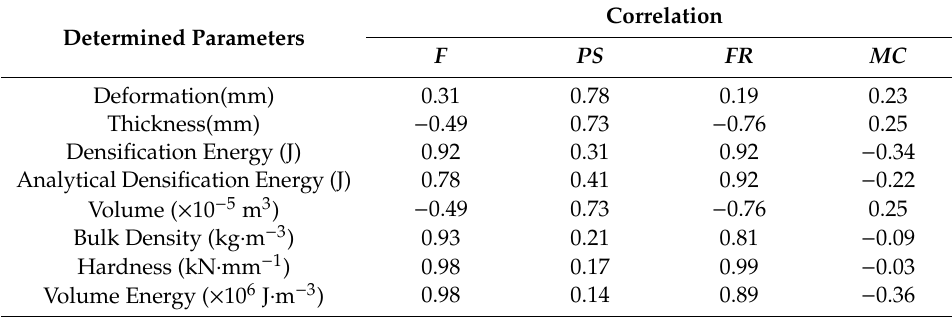
Table 10. Correlation results of parameters against force, particle size, and moisture content of ground hazelnut husk briquettes.